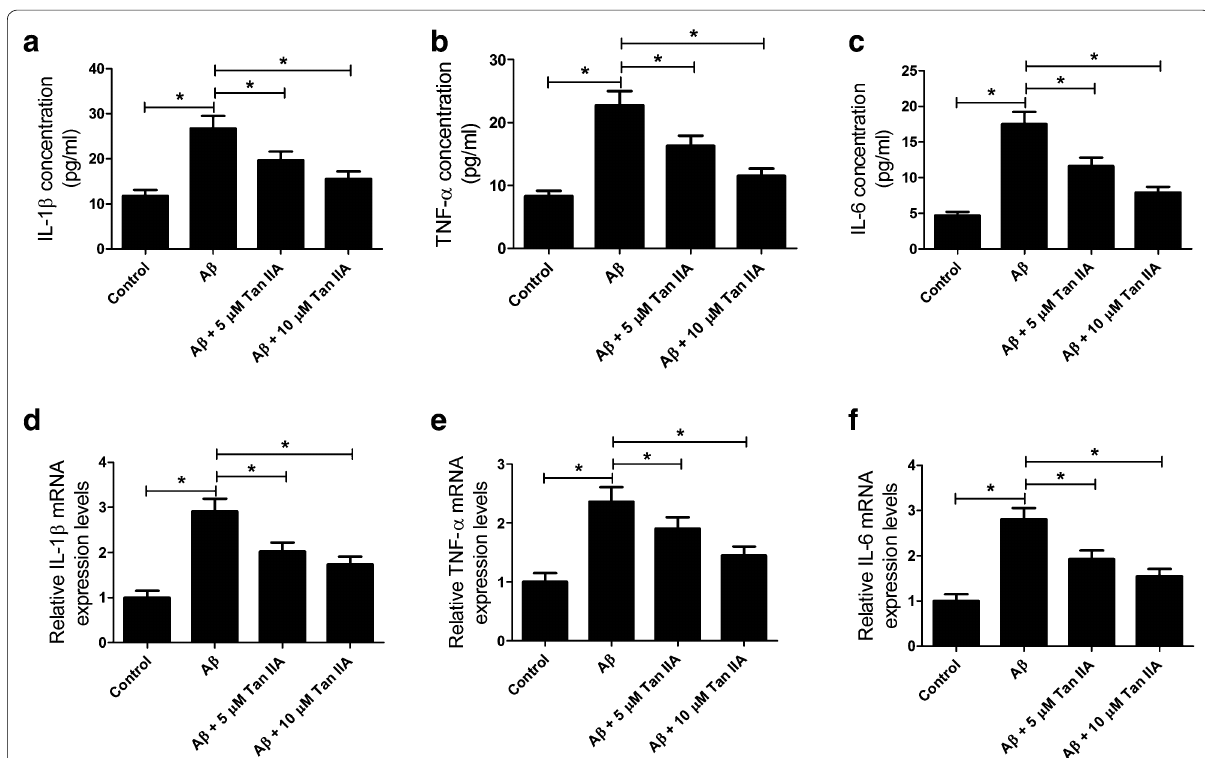
Fig. 5 Tan IIA alleviated the inductive effect of Aβ on the expression of inflammatory factors in SH-SY5Y cells. SH-SY5Y cells were preconditioned with Tan IIA (5 or 10 μM) for 1 h followed by treatment with Aβ (25 μM) for 48 h. a – c ELISA assay examined the concentration of TNF-α, IL-1β and IL-6 in the culture supernatant. d – f qRT-PCR analysis evaluated the mRNA levels of TNF-α, IL-1β and IL-6 in SH-SY5Y cells. * p < 0.05, ** p < 0.01 vs. respective